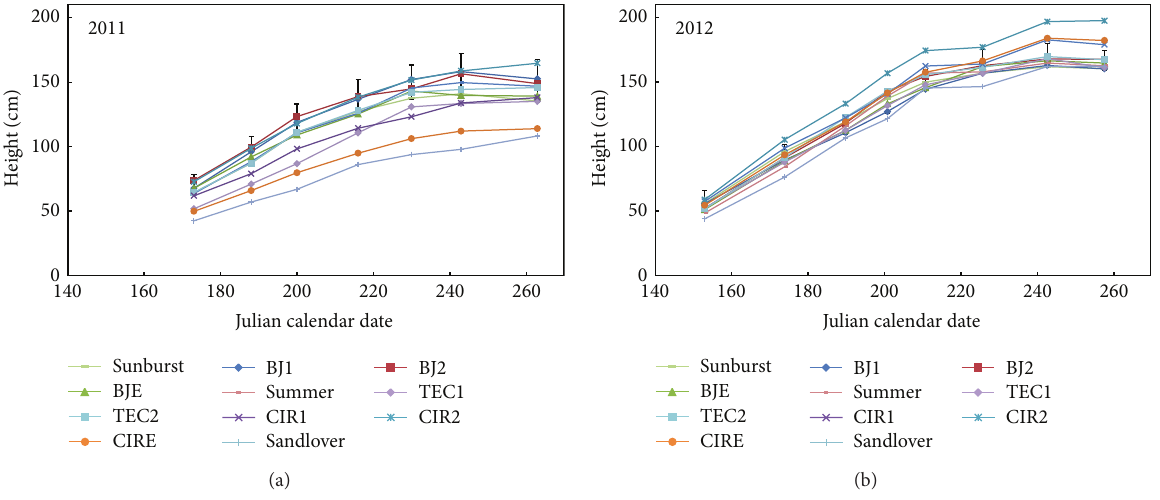
Figure 4: Height of 11 selections of switchgrass at Cookshire-Eaton, Quebec, in 2011 and 2012. Vertical bars represent the least significant difference (LSD, 𝑃 = 0.05 ) at each sampling point throughout the season. BJ1, Blue Jacket; BJ2, Blue Jacket II; BJE, Blue Jacket Early; TEC1, Tecumseh; TEC2, Tecumseh II; CIR, Cave-in-Rock; CIR2, Cave-in-Rock II; CIRE, Cave-in-Rock